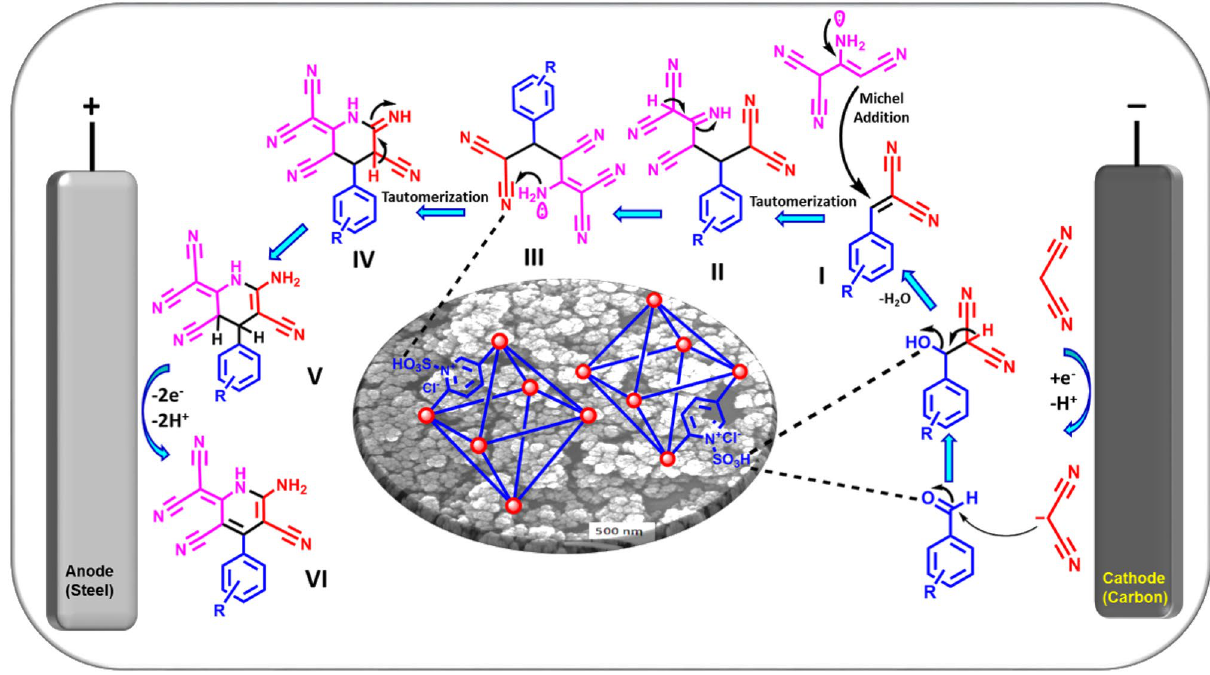
Figure 10. Convergent paired electrochemical synthesis of dicyanomethylene pyridine compounds.